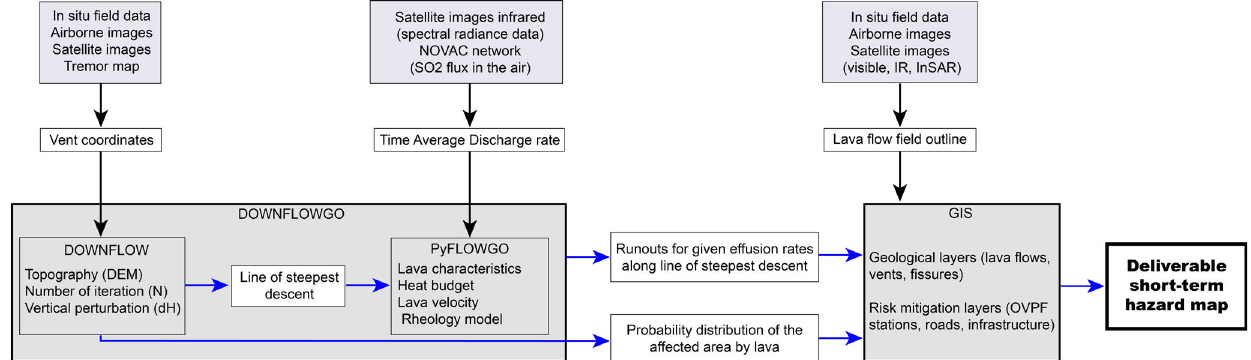
Figure 2: Protocol for the near real-time hazard assessment response at Piton de la Fournaise since 2018. From top to bottom, the first level (light grey boxes) are the input data collected during the eruption. The second level (white boxes) are the output parameters collected in level 1 and used to implement the software in level 3. The third level (dark grey) are the two employed software DOWNFLOWGO and any Geographic Information System. DOWNFLOWGO is composed of (i) DOWNFLOW that needs the topog- raphy (DEM) and the calibrated simulation parameters ( Δ h and N ) and computes the line of steepest descent (LoSD) and the probable lava flow area, and (ii) PyFLOWGO that uses the lava thermo-rheological properties to compute the runout distances along the LoSD for a given effusion rate. The GIS needs to contain all required layers (geology and infrastructure) and a map template so to produce the consistent final product that is the short-term lava flow hazard map to be delivered to the authorities. Acquired lava flow outline by field and airborne survey or satellite data acquired during the eruption can be added as a layer as and when